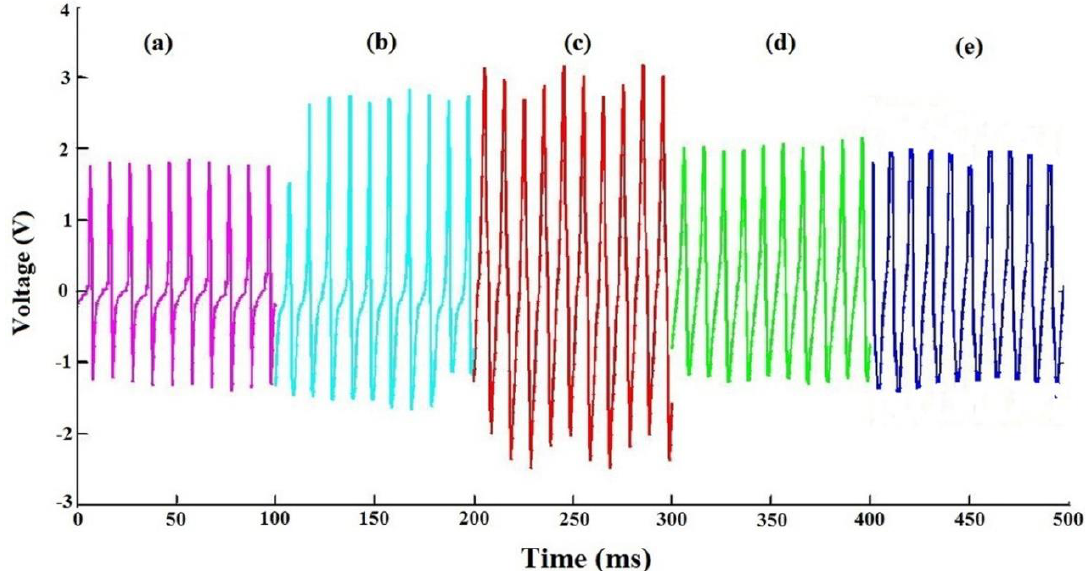
Figure 5. Piezoelectric response of the electrospun PVDF/LiCl nanogenerator obtained using the base motion of a shaker at 200 HZ frequency for different web thicknesses: ( a ) 150, ( b ) 250, ( c ) 350, ( d ) 450, and ( e ) 550 μm.